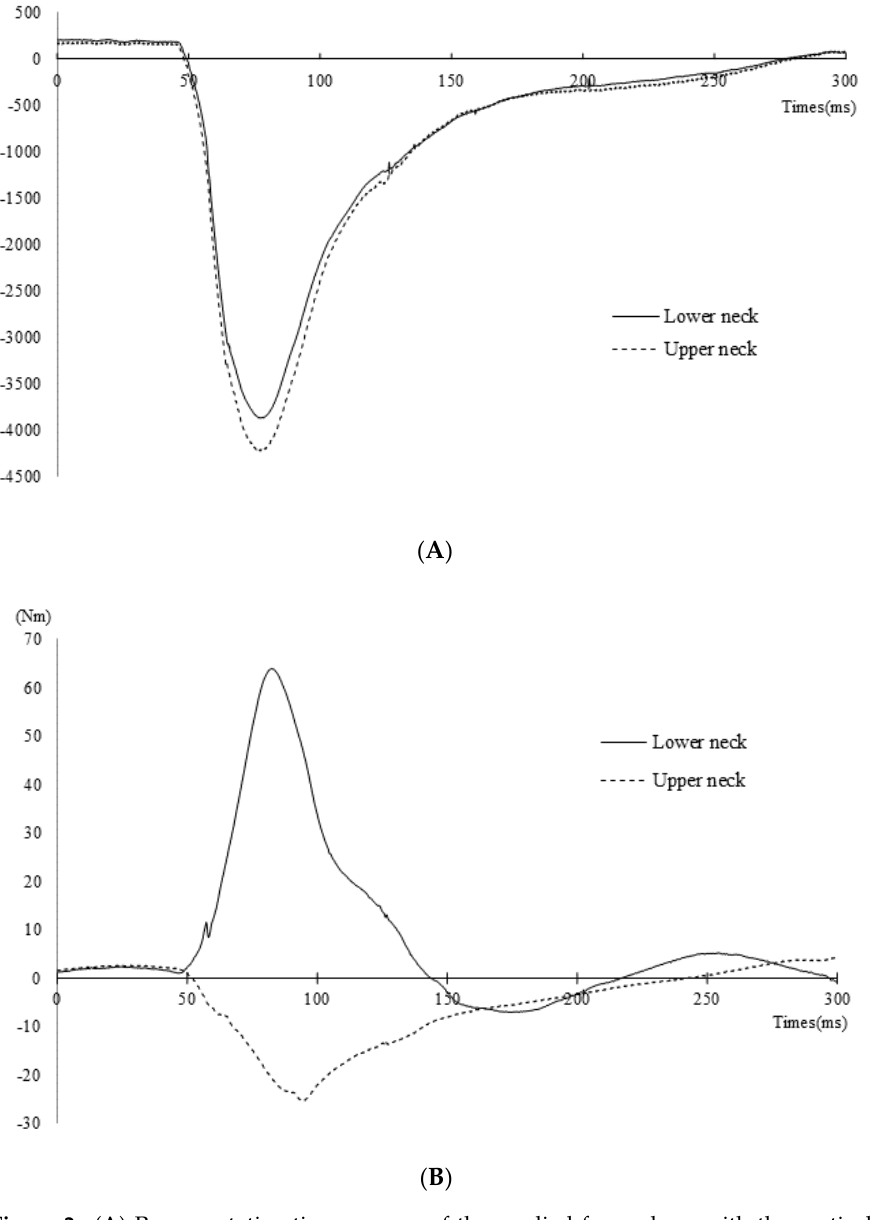
Figure 2. ( A ) Representative time courses of the applied force along with the vertical direction when thrown by Seoi-nage . ( B ) Representative time courses of the bending moment along with the anterior–posterior direction when thrown by Seoi-nage